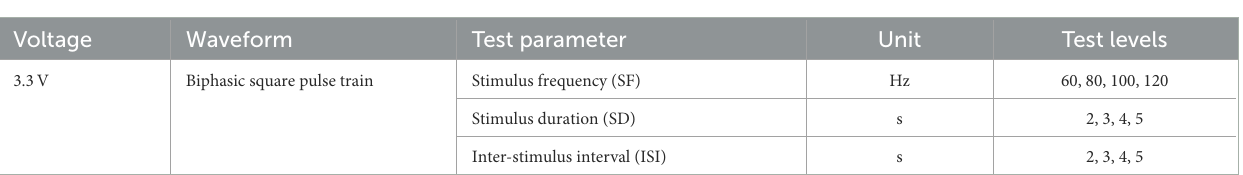
TABLE 1 Parameter test